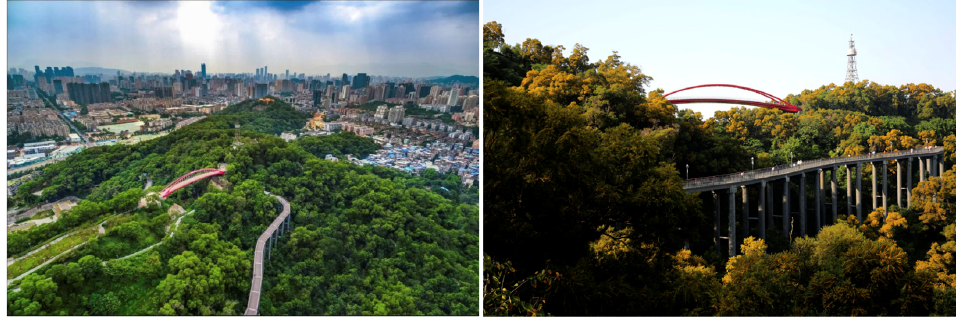
Figure A5. The pictures of “City Viewing Plank Road” of Jinji Mountainous Park in Fuzhou.